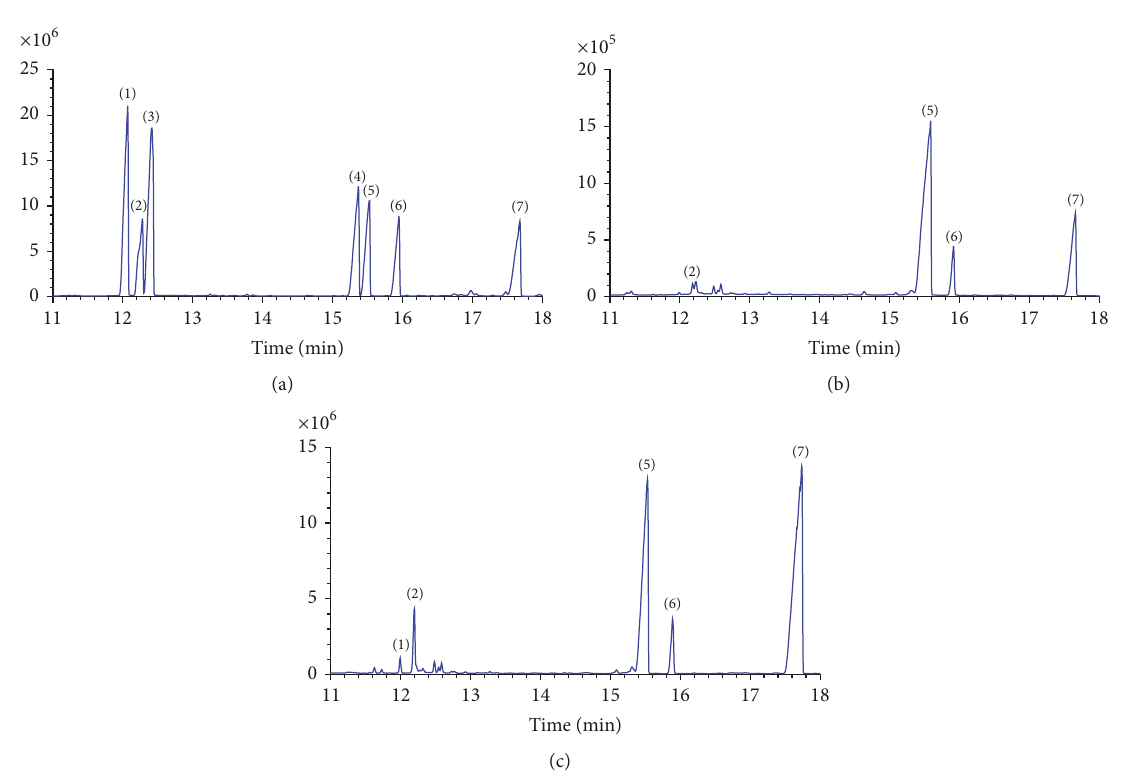
Figure 5: GC-MS analysis of monosaccharide composition of derivatives of (a) six standards, (b) RGP1 and (c) RGP2-1. (1) Rhamnose; (2) arabinose; (3) xylose; (4) mannose; (5) glucose; (6) galactose; (7)